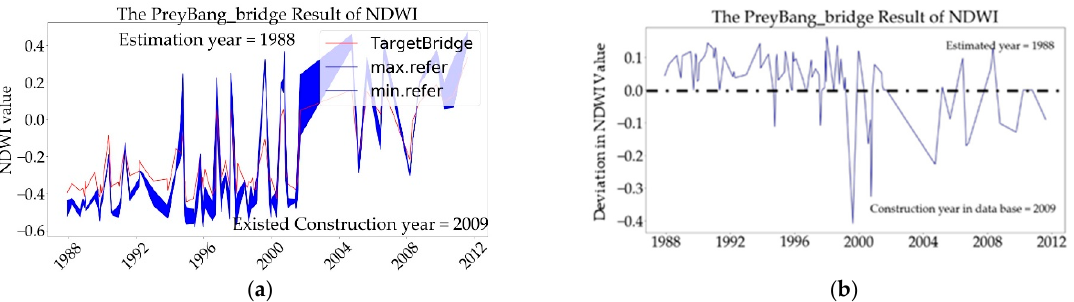
visualization of ( a ) showing the NDWI difference; no clear change is apparent.